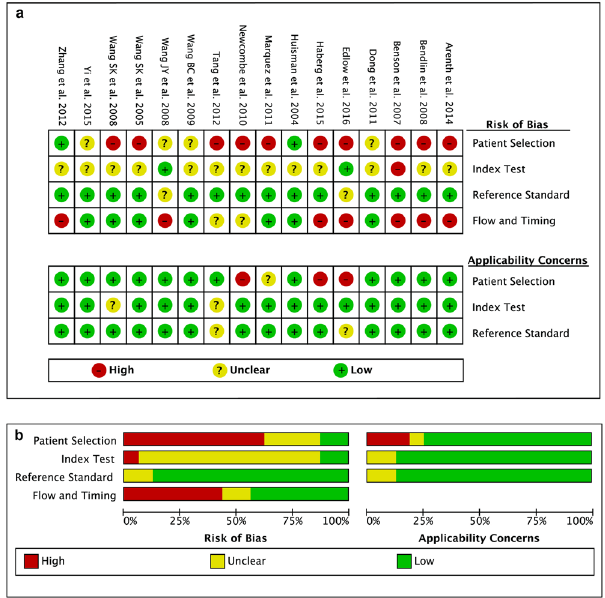
Figure 2. Assessment of risk of bias and clinical applicability. ( a ) Risk of bias summary. ( b ) Risk of bias